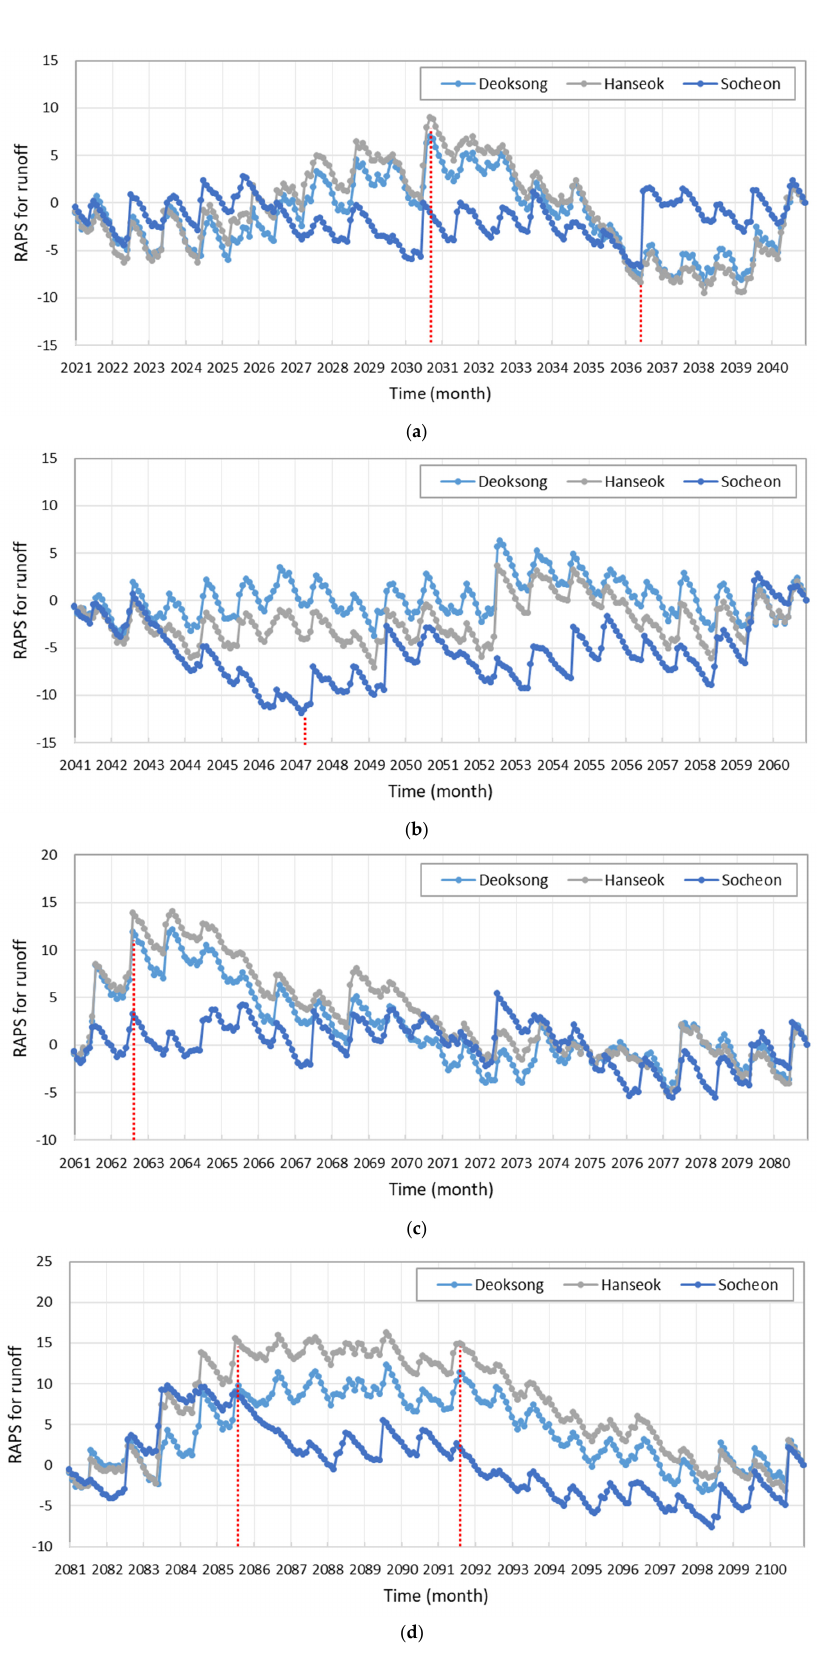
Figure 7. Future discharge simulation results of the Socheon SHP plant basin. ( a ) Monthly average discharge: Period I (2021–2040), ( b ) monthly average discharge: Period II (2041–2060), ( c ) monthly average discharge: Period III (2061–2080), ( d ) monthly average discharge: Period IV (2081–2100). The future runoff change in each basin under climate change was analyzed. Based on the results, the SHP potential of each plant was calculated. In this instance, the plants were assumed to operate until 2100 for the analysis even though the average lifespan of SHP plants is approximately 50 years. Table 8 shows the results of estimating the annual SHP potential of each SHP plant. Table 8. Estimated annual SHP potential by SHP plant (2021–2100) [unit: MWh]. Year Deoksong Hanseok Socheon Year Deoksong Hanseok Socheon 2021